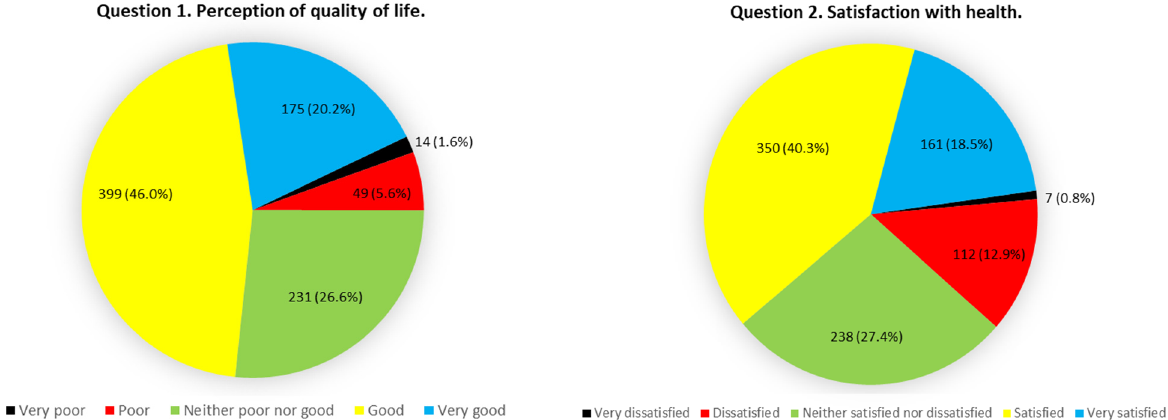
Figure 2. Participants’ perception of their quality of life and satisfaction with their health.